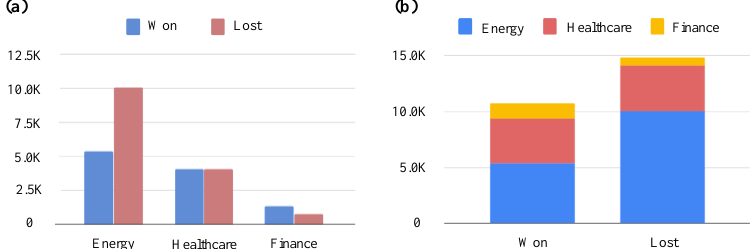
Figure 1. Data Exploration: ( a ) Distribution of sales opportunity records across the three business segments: Healthcare, Energy, and Finance. ( b ) Closed sales opportunities final status.